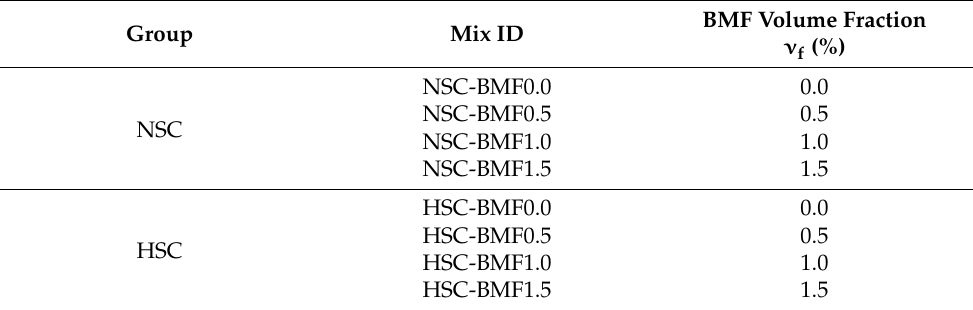
Table 1. Test Matrix.